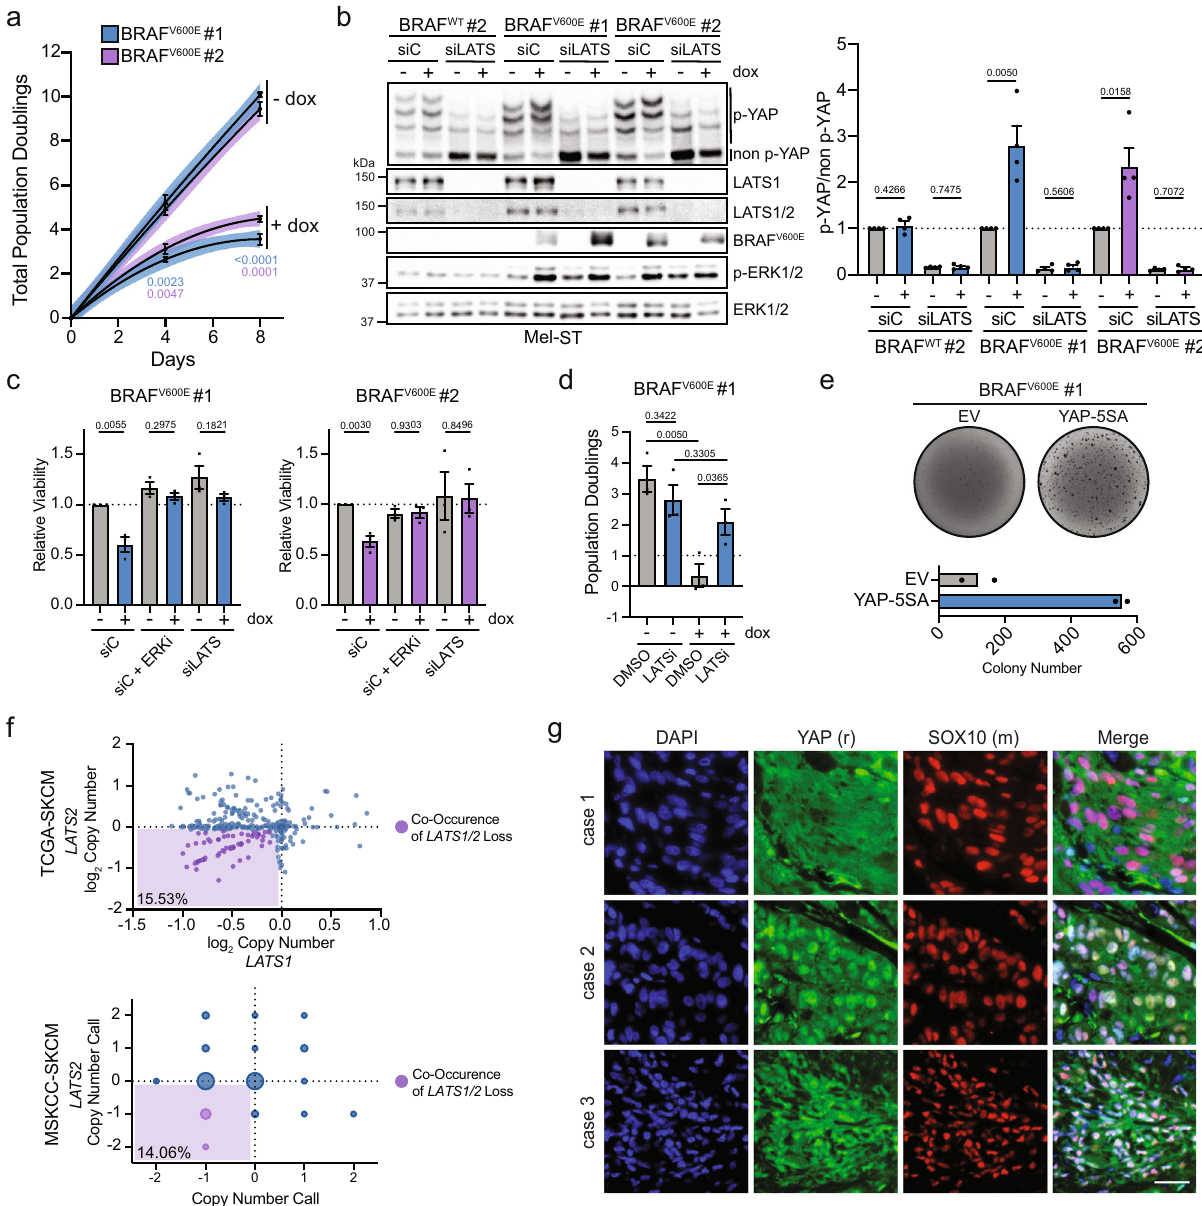
Fig. 3 Oncogenic BRAF-induced Hippo pathway activation restrains melanocyte growth. a Population doubling assay of two dox-inducible BRAF V600E Mel-ST clones ± dox ( n = 3 independent experiments, lines represent second-order polynomial non-linear fi t, line color represents 95% con fi dence interval (dots show mean ± SEM, two-tailed unpaired t test). b Left, representative IB of two dox-inducible Mel-ST clones treated with control siRNA (siC) or LATS1 and LATS2 siRNAs (siLATS) ± dox for 24 h; right, intensity quanti fi cation of YAP phos-tag ( n = 4 independent experiments, graph shows mean ± SEM, two-tailed unpaired t test). c Relative viability of Mel-ST cell lines treated with indicated siRNA or drugs for a 4-day period ( n = 3 independent experiments in technical quintuplicate, graphs show mean ± SEM, two-tailed unpaired t test). d Number of population doublings of indicated dox-inducible Mel-ST clone over 4 days treated with either DMSO or a LATS1/2 inhibitor (LATSi), ± dox ( n = 3 independent experiments, graph shows mean ± SEM, two-tailed unpaired t test). e Representative crystal violet stain of dox-inducible BRAF V600E Mel-ST cell line expressing indicated genes grown in dox-containing soft agar with quanti fi cation below ( n = 2 independent experiments in technical triplicate, graph shows mean). f Plot of log 2 copy-number values from TCGA- SKCM or GISTIC 2.0 calls from MSKCC-SKCM databases for the genes LATS1 and LATS2 ; bottom left percent is the frequency of LATS1/2 co-heterozygous loss. g Representative immuno fl uorescence staining of indicated proteins in three human melanoma cases, scale bar = 25 µ m). Source Data are provided as a Source Data fi